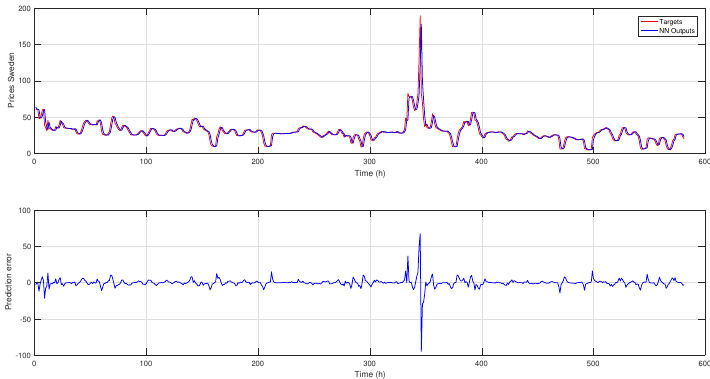
Figure 10. Energy price forecasting for Norway time series data.